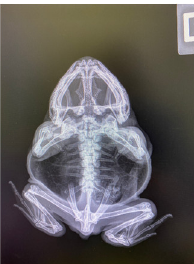
Figure 3. X-Ray, ventral dorsal projection of the frog, absence of bony changes in the right orbit. On cytological examination, specimens were poorly cellular differentiated and showed neutrophilic-macrophages inflammation with the presence of septate fungal hyphae (Figure 4). At histopathological examination, pigmented hyphae, and structures consistent with muriform bodies were found on a background of diffuse granulomatous inflammation from collected tissue samples (Figure 5).